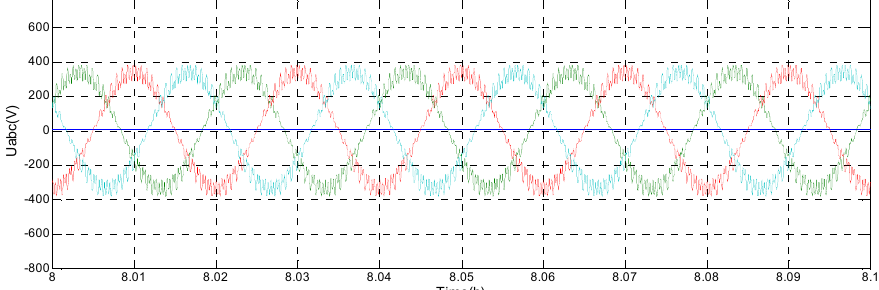
Figure 13. Grid − connected voltage under pulse width modulation (PWM) control.